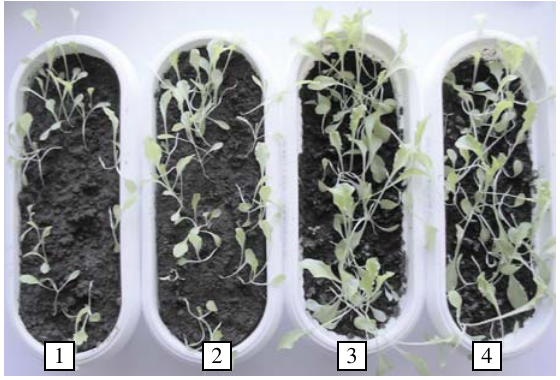
Fig 4. Lettuce samples were grown in substrates of differ- ent composition: 1, 2 – soil; 3, 4 – sewage sludge